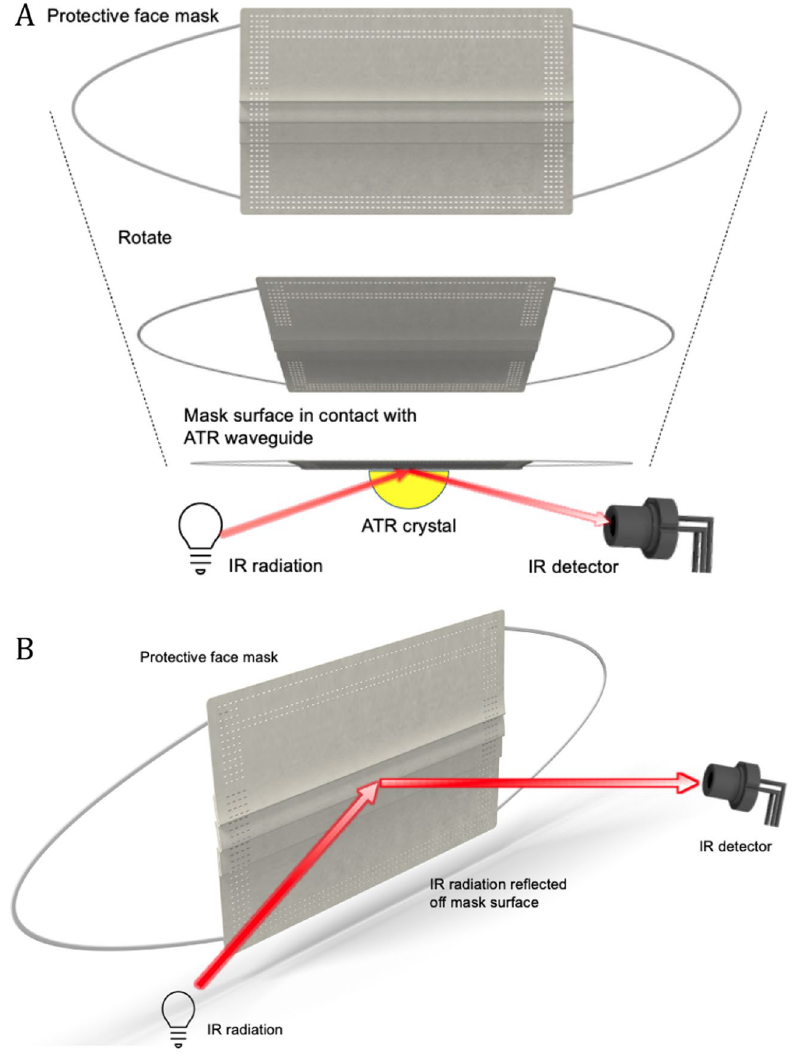
Figure 1. Schematic illustration of ( A ) attenuated total reflection (ATR), and ( B ) external reflection (ER) infrared spectroscopy 20